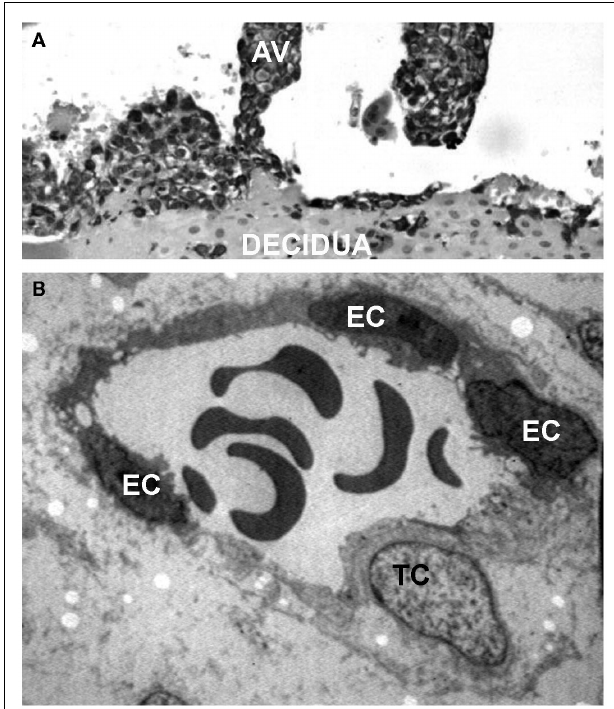
FIGURE 1 | Interstitial and endovascular invasion of trophoblast cells. (A) Histological section of first trimester placenta stained for cytokeratin 7, showing an anchoring villi (AV). (B) Transmission electron microscope image of a remodeled vessel in which a trophoblast cell (TC) lines the vascular wall together with endothelial cells